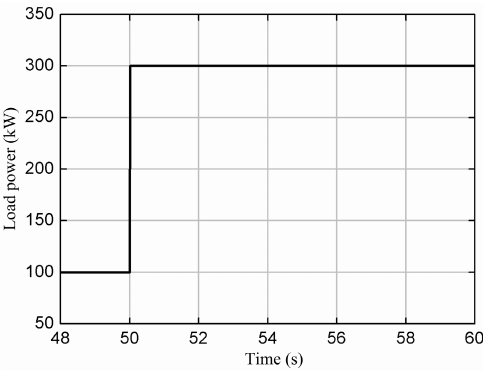
Figure 16. Load power step.